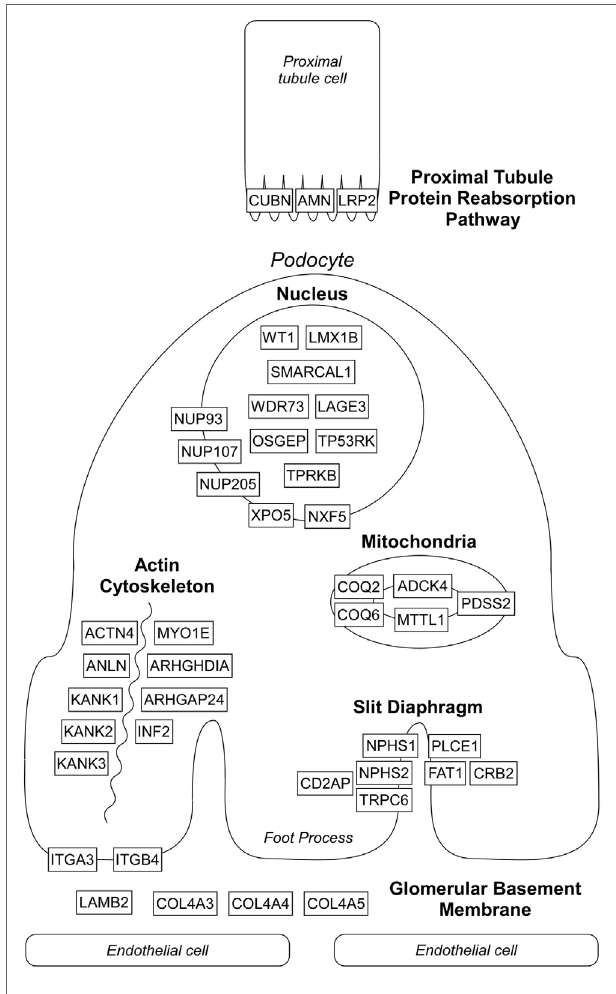
FiGURe 1 | Localization of affected proteins in monogenic causes of proteinuria. Please see text and Table 1 for details. Diagram does not depict all genes listed in Table 1 known to cause proteinuria and nephrotic